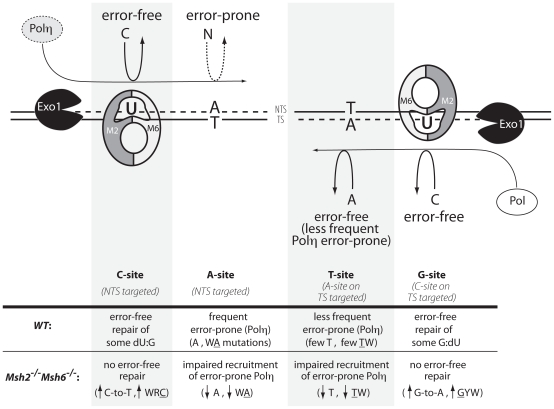
Model for MMR resolution of AID-generated dU:G mispairs.In the DNA deamination model, MSH2/MSH6 recognizes the initial AID-generated dU:G lesion, the damaged strand is excised by Exo1, and Polη is preferentially recruited to the nontranscribed strand (NTS) to generate mutations at A sites within WA motifs. Fewer T sites within TW motifs are mutated, contributing to the singular A≫T and WA≫TW biases that characterize SHM and reflect the reduced targeting of A sites by Polη in the transcribed strand (TS). We highlight here the error-free repair effect of MMR at the dU:G mispairs within the excised patch, which is revealed in Msh2−/−Msh6−/− mice by a significant increase in unrepaired dU:G lesions that are replicated as transitions at C:G sites in WRC/GYW hotspots (i.e. C-to-T within WRC in the NTS, and G-to-A within GYW as a reflection of C-to-T mutations in the TS).